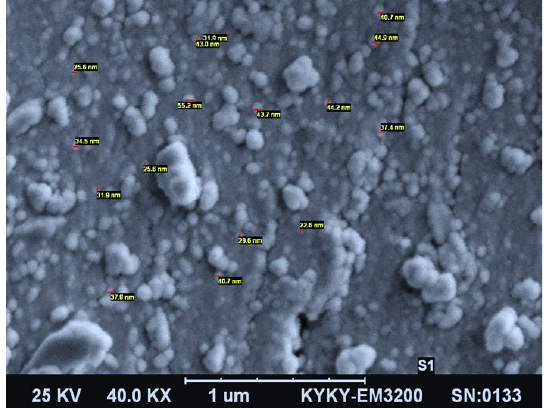
Fig. 1. SEM image of synthesis SiO